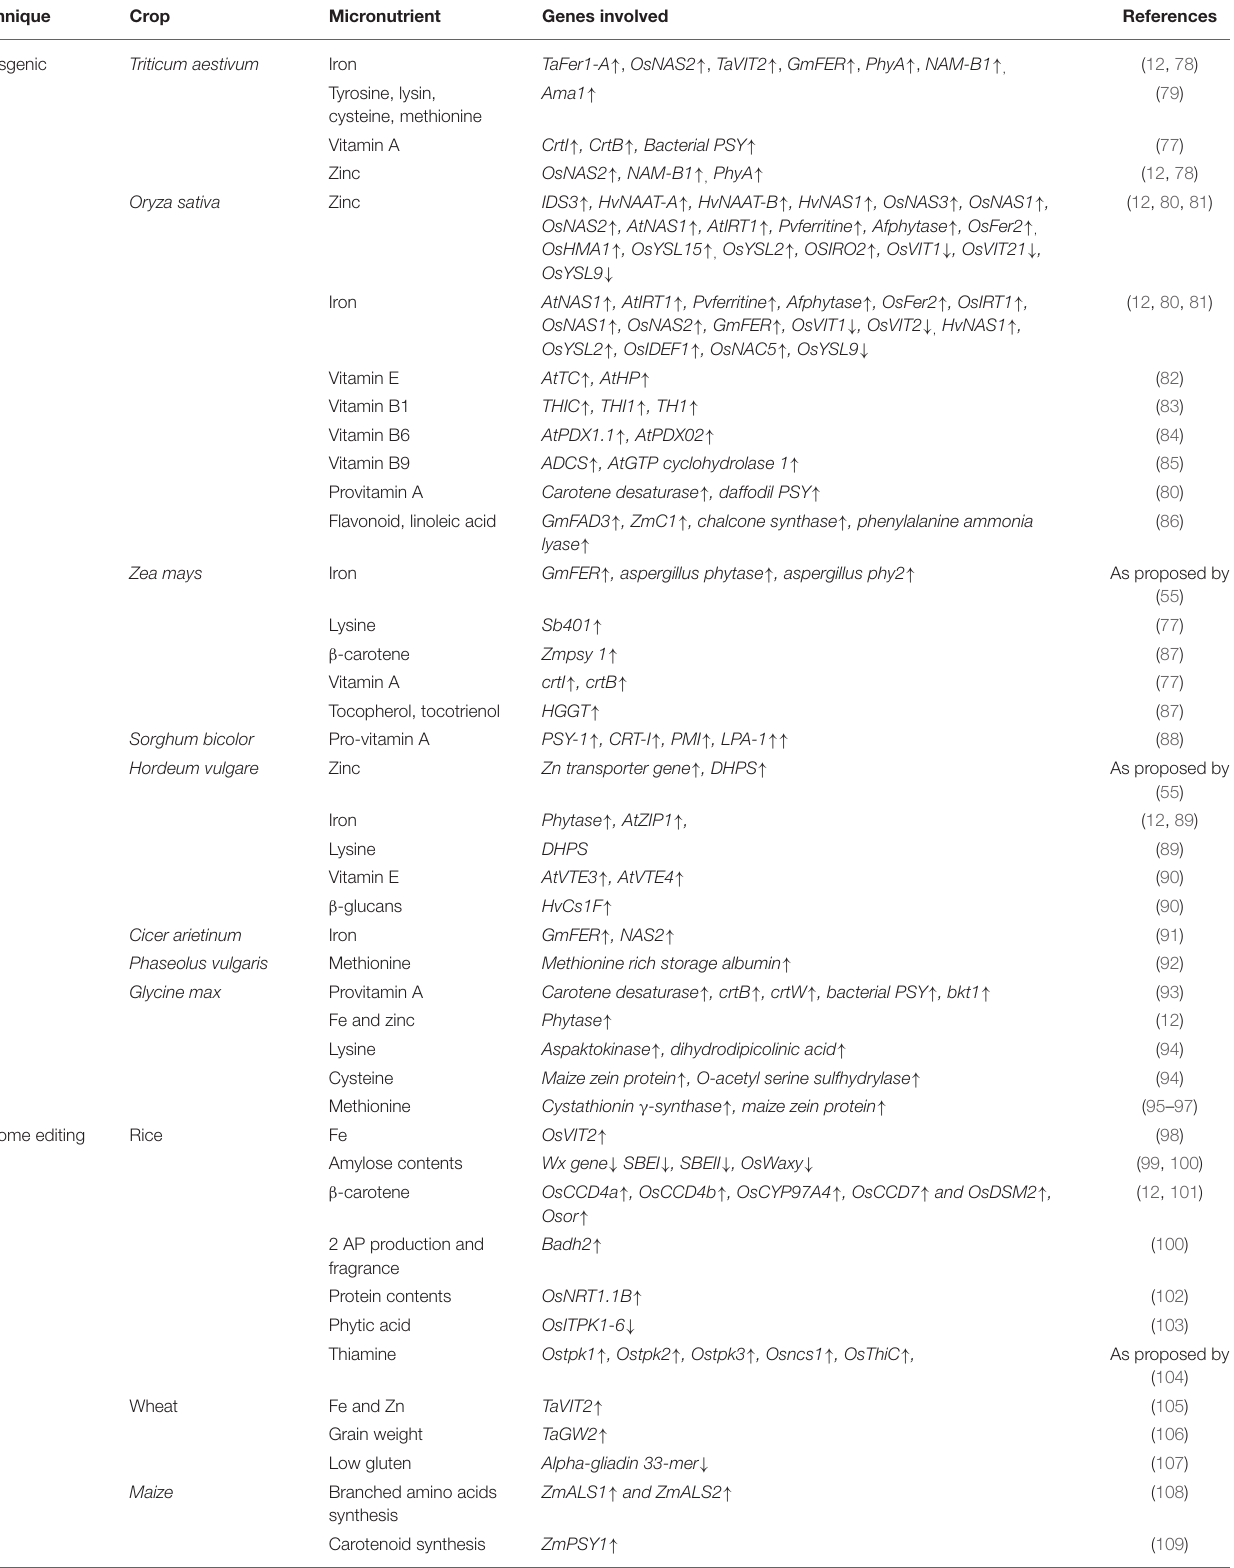
TABLE 3 | Summary of studies explaining biofortification of crops through transgenic breeding and genome